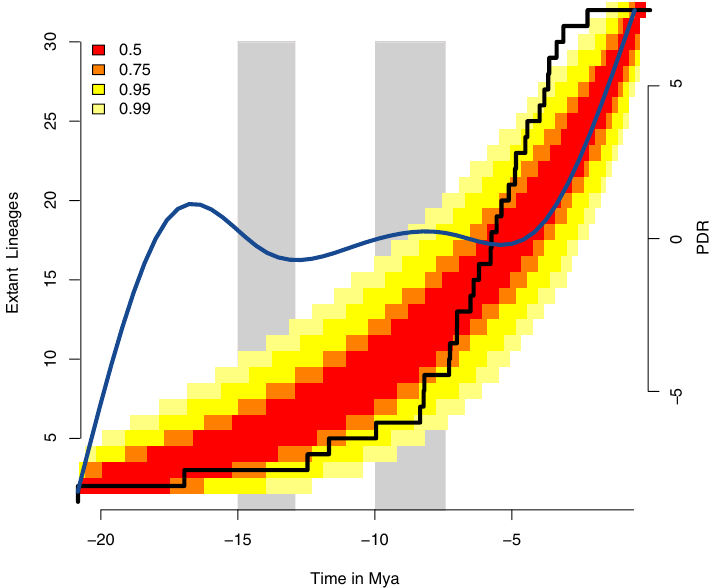
Figure 3. Tempo and mode of evolutionary diversification in Hypostomus within La Plata Basin. The black line shows the lineage through time (LTT) curve of species accumulation over time. Colors are the confidence intervals of a neutral model. Blue line is the Pulled Diversification Rate (PDR) over time. Grey vertical bars are the maximum flooding events of the Miocene Marine